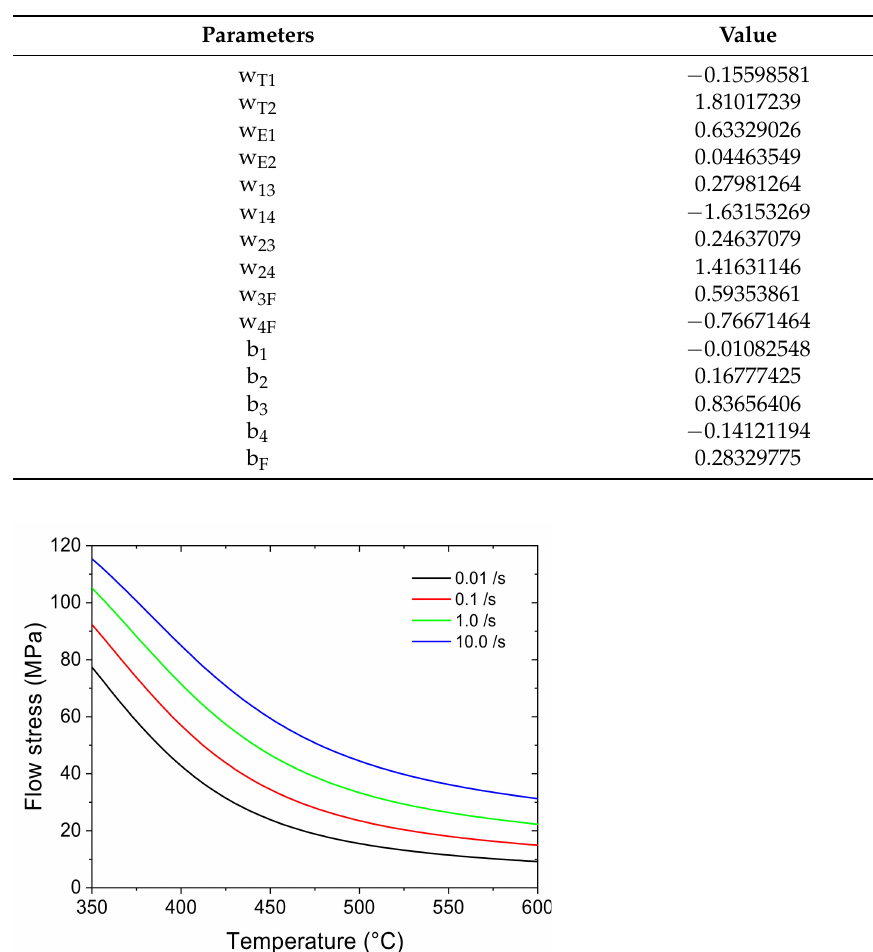
Table 4. Coefficients of the ANN for predicting the flow stress.